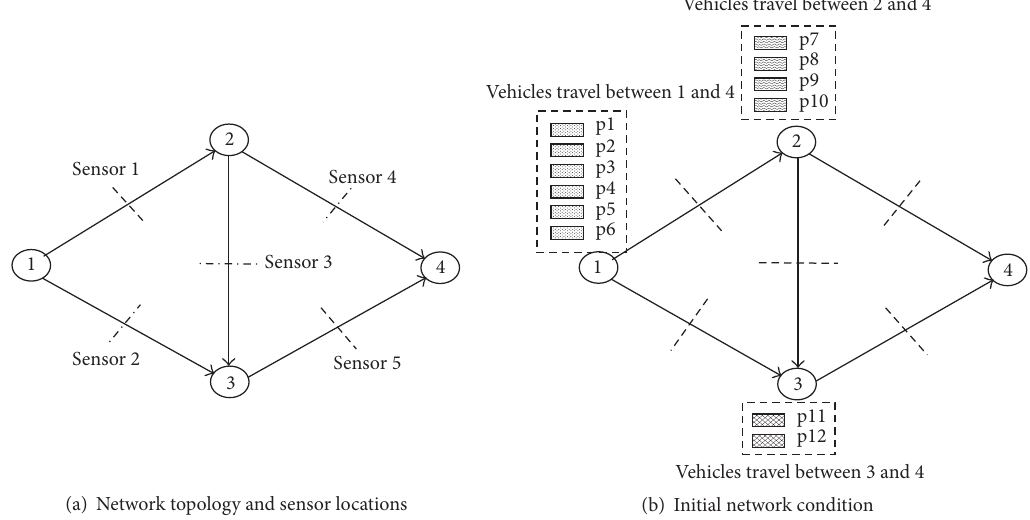
Figure 1: Network topology and initial probe vehicle locations.